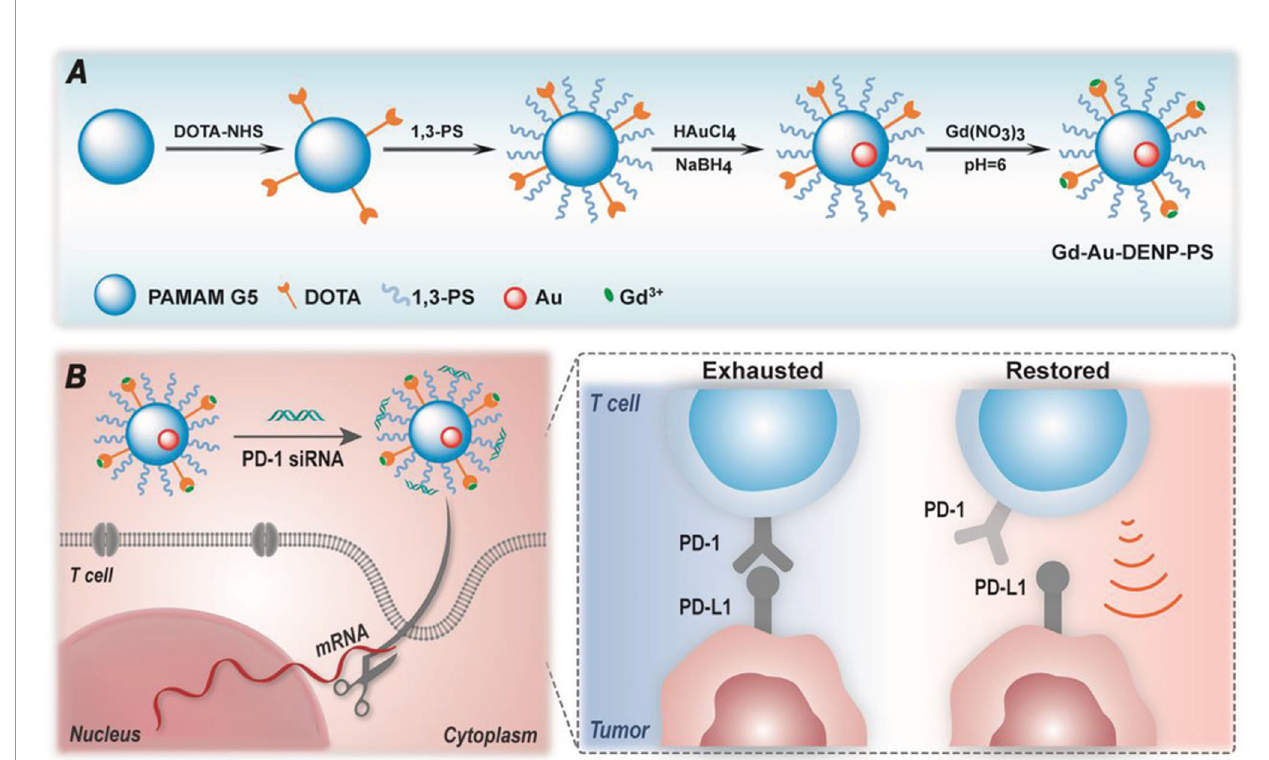
FIGURE 8 | Schematic diagram of design of the dendrimer-encased AuNP from Shi et al. (A) Sequential coupling of DOTA and 1,3-propane sultone followed by AuNP formation and Gadolinium ligation. (B) Capping with PD-1 siRNA, followed by delivery to a T-cell results in reduced PD-1 expression and restoration of T-cell antitumor